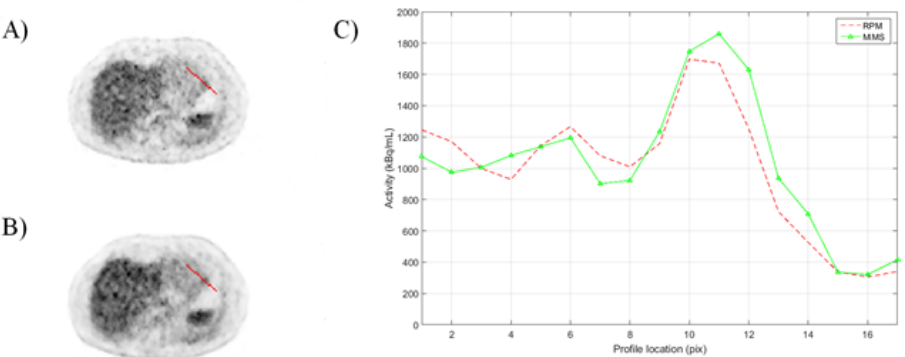
Figure 8. A visualization of ( A ) MMS-gated, ( B ) RPM-gated reconstructed PET images showing the region of the hot spot and ( C ) profiles between the MMS-gated and RPM-gated reconstructed